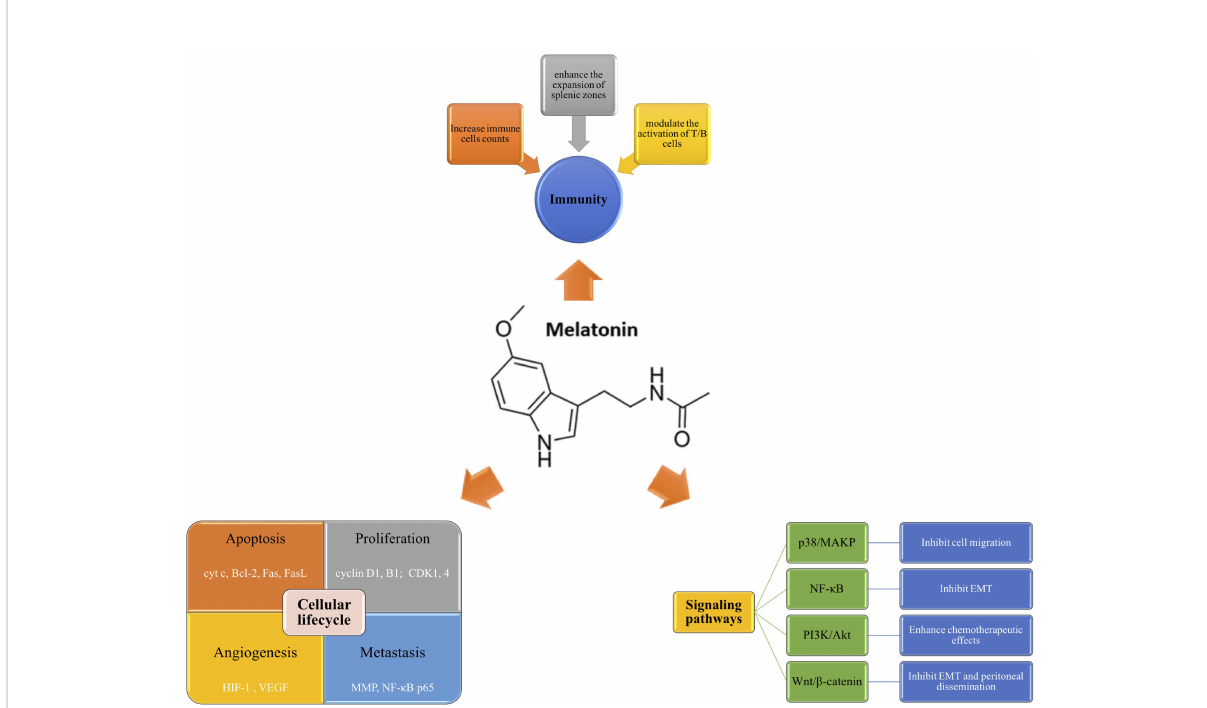
FIGURE 3 Mechanisms of melatonin in GI carcinogenesis. Melatonin plays a role in anti-carcinogenesis mainly through the following ways, including modulating cellular lifecycle, regulating immunity function, and involving several oncogenic signaling pathways. Melatonin can induce cell apoptosis via regulating multiple genes (cyt c, Bcl-2, Fas) and inhibit proliferation by arresting cancer cell cycle (cyclin D1, cyclin B1, CDK1, CDK 4). Moreover, it can also in fl uence the angiogenesis and metastasis by modulating HIF-1, VEGF, MMP, etc. Secondly, melatonin is a regulator of immunity. It mediate the immune function mainly through increasing the counts of immune cells, enhancing the expansion of splenic zones, and activating the function of T/B cells. Thirdly, melatonin can inhibit carcinogenesis through speci fi c signaling pathways, such as p38/MAPK, NF- k B, PI3K/Akt, and Wnt/ b -catenin. Bcl-2, B-cell lymphoma-2; cyt c, cytochrome c; EMT, epithelial-mesenchymal transition; FasL, Fas ligand; HIF-1, hypoxia-inducible factor 1; MAPK, mitogen-activated protein kinase; MMP, matrix metalloproteinases; NF- k B, nuclear factor-kappa B; PI3K, phosphoinositide 3 Kinase; VEGF, vascular endothelial growth